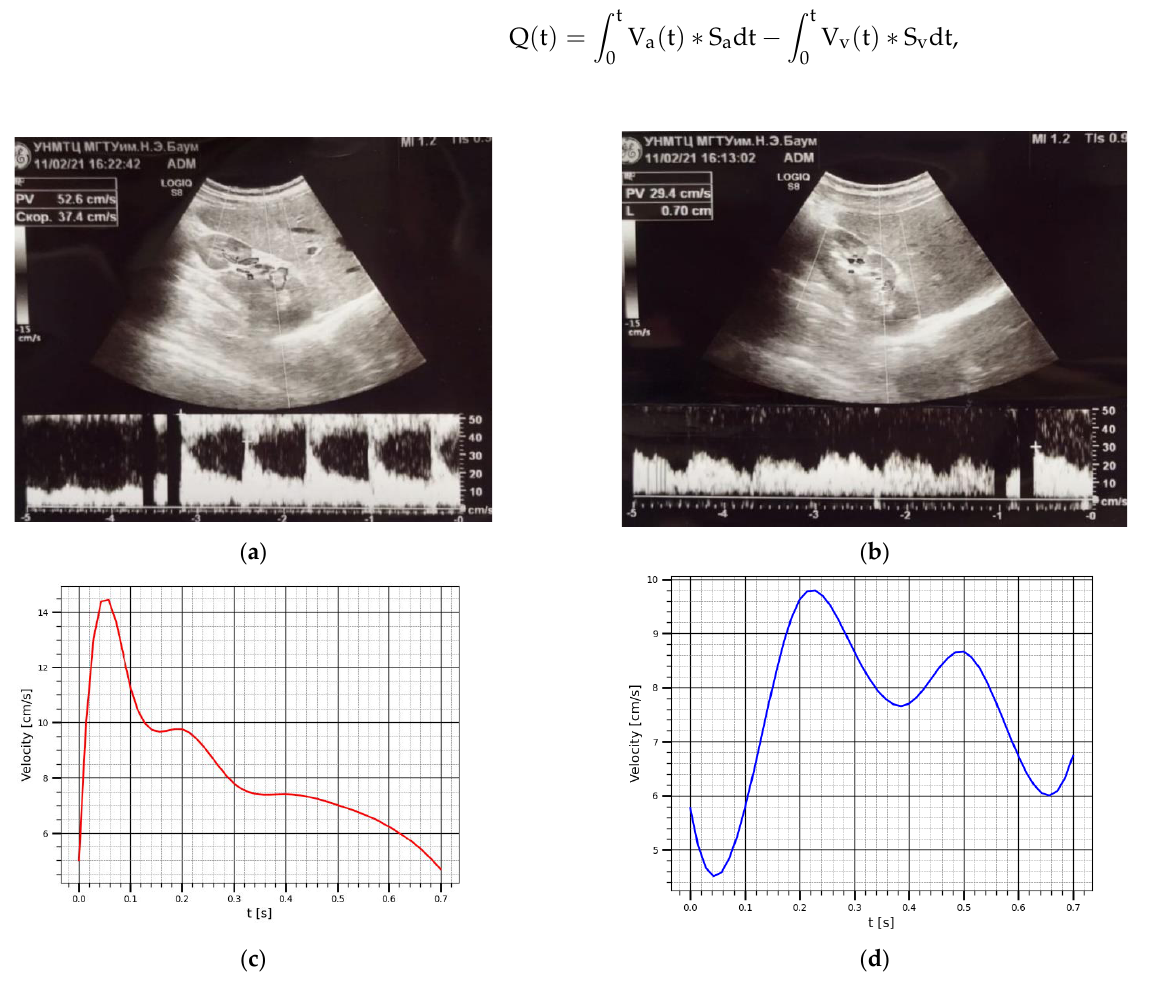
Figure 9. This velocity curves obtained using ultrasound: ( a ) The renal artery blood velocity; ( b ) The renal vein blood velocity; ( c ) The averaged renal artery blood velocity; ( d ) The averaged renal vein blood velocity.